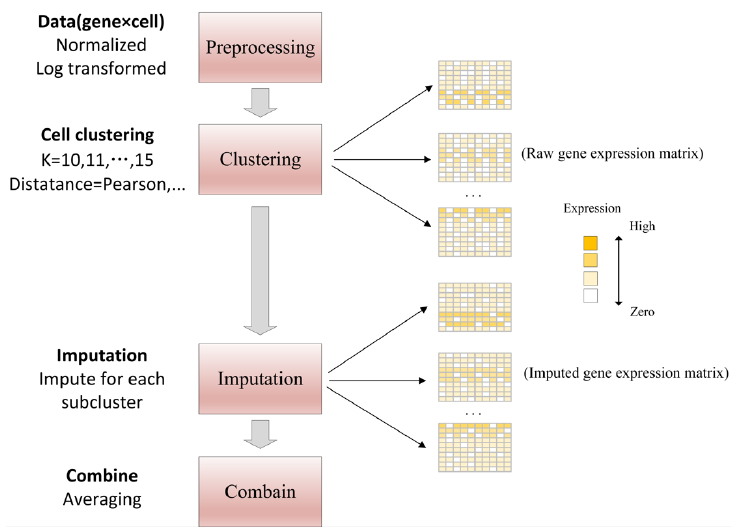
Figure 10. The framework of DrImpute method [49].